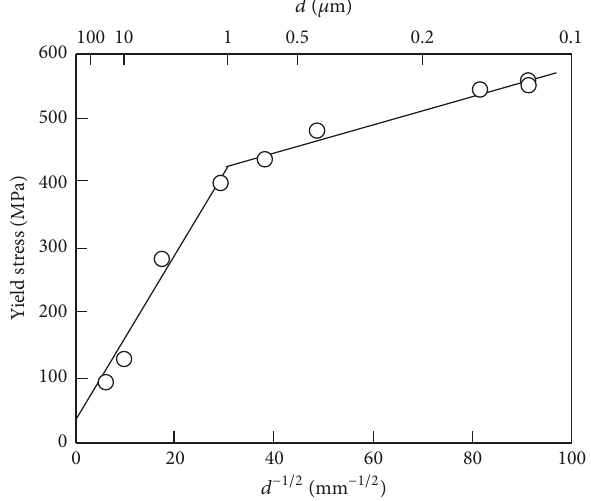
Figure 6: Relationship between yield stress and the inverse square root of grain size.